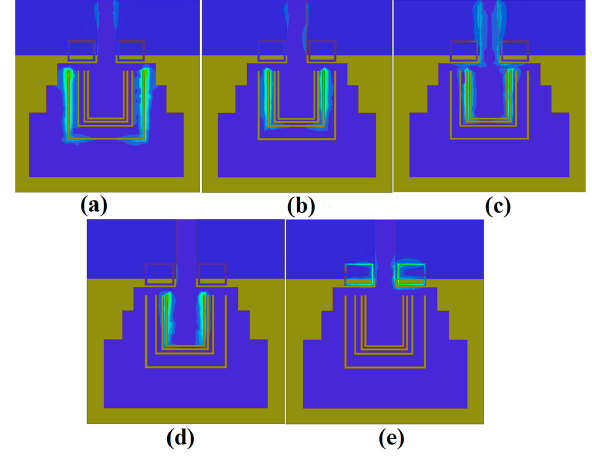
Figure 6. Surface current distributions of the proposed antenna at the corresponding center frequencies of the notched bands ( a ) 3.5 GHz; ( b ) 4.5 GHz; ( c ) 5.25 GHz; ( d ) 5.7 GHz; ( e ) 8.2